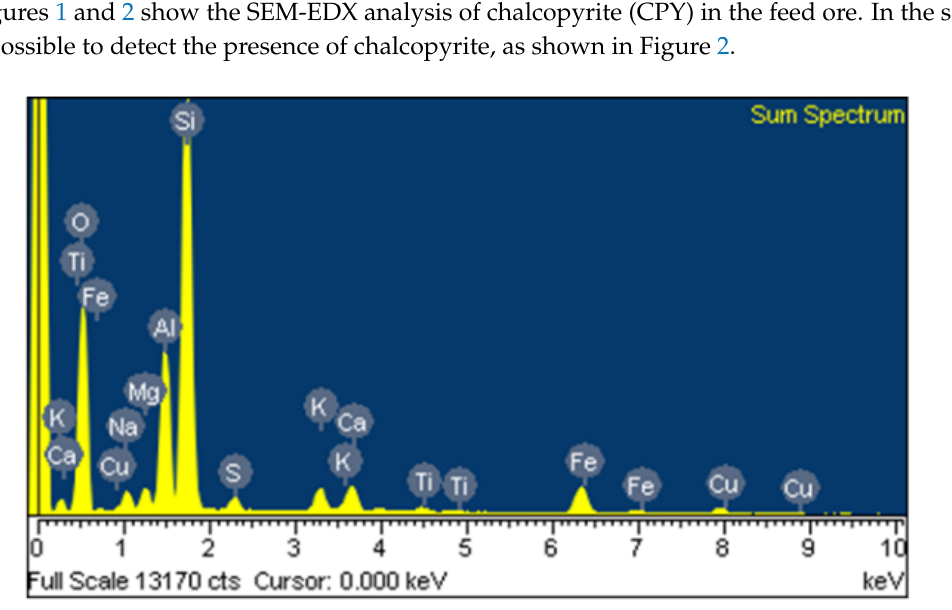
Figure 1. Elemental composition obtained by SEM-EDX analysis of Chalcopyrite (CPY) in the feed ore sample.